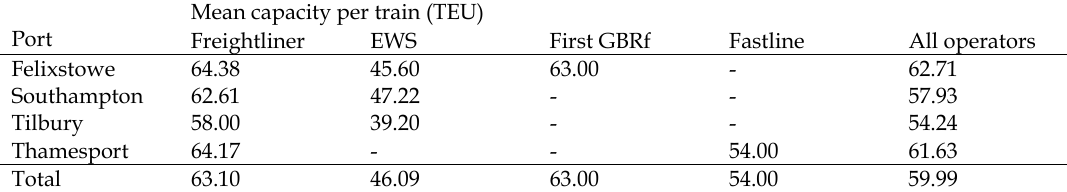
Table 4. Mean TEU capacity provided per train, by port and train